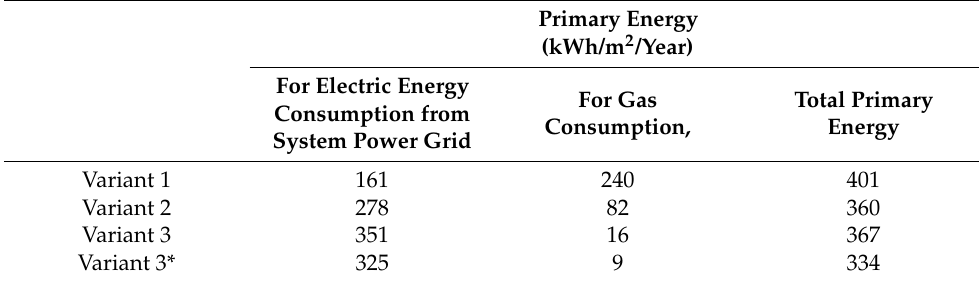
Table 4. Primary Energy values for all calculation